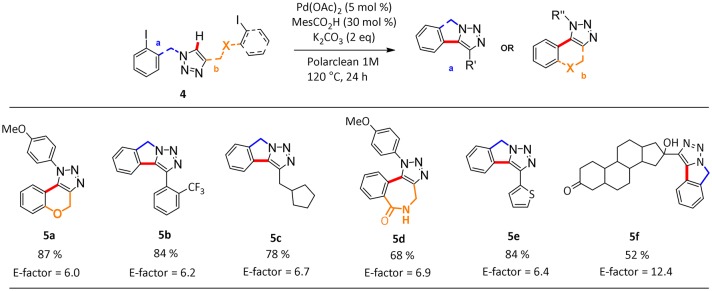
Scope of hetero-fused triazoles 5a-fa. aData reported refer to the isolated yield of the pure product. aReaction conditions: 4a (1 mmol), MesCO2H (30 mol %, 0.3 mmol), K2CO3 (2 equivalent, 2 mmol), Pd(OAc)2 (5 mol %, 0.05 mmol), Polarclean 1 mL, 1 M.